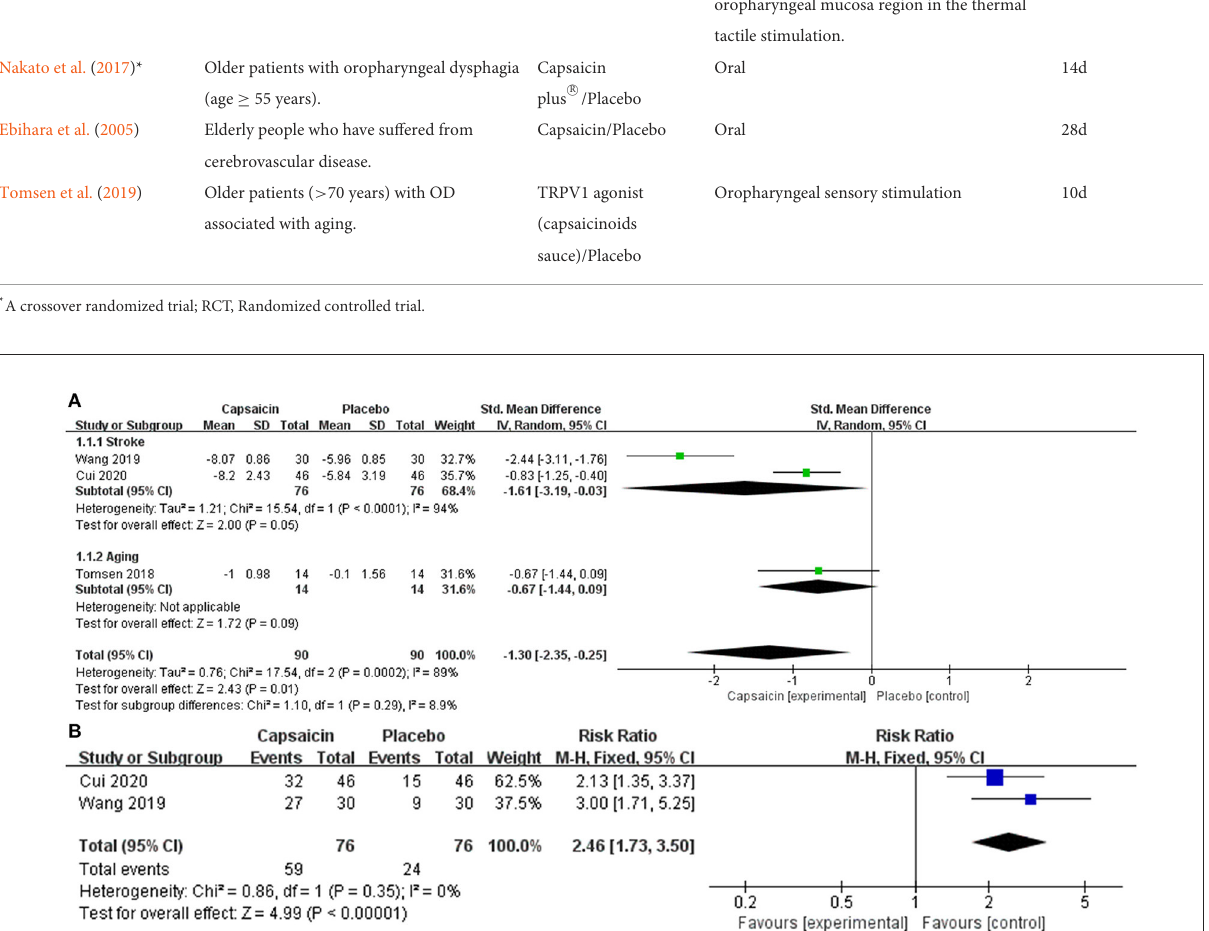
et al., 2019), one in the capsaicin intervention group and one in the placebo control group. No treatment-related adverse events were identified in the other five